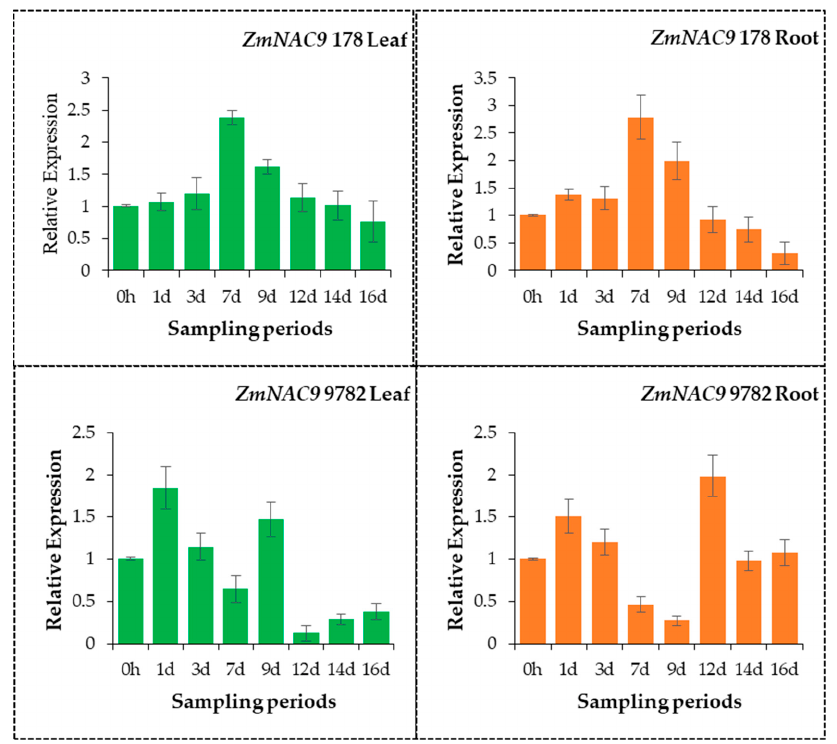
Figure 8. Expression pattern of ZmNAC9 in roots and leaves of P-tolerant 178 and P-sensitive 9782 inbred lines under low-P conditions in maize seedling. Plants 2020 , 9 , x FOR PEER REVIEW